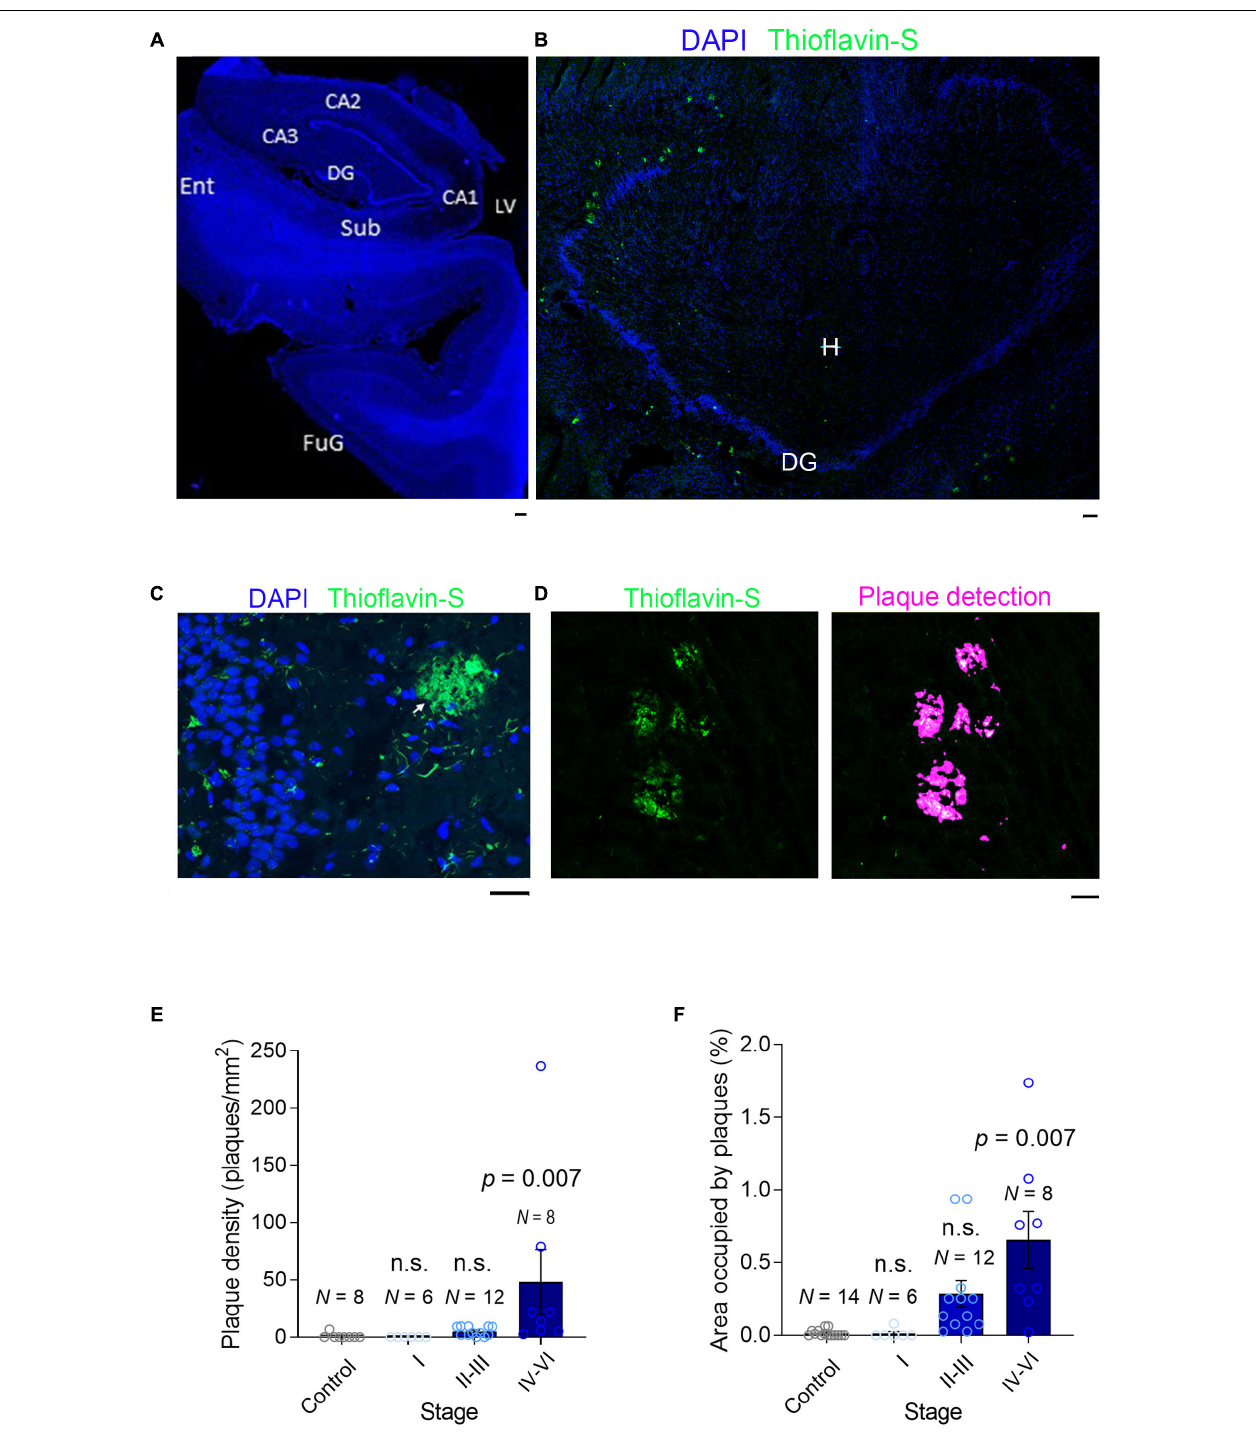
FIGURE 2 | Plaque detection in AD samples. (A) A slide scanner image ( × 5) of a DAPI-stained section (stage II) containing the hippocampal formation: Sub, Subiculum; Ent, Entorhinal Cortex; DG, Dentate Gyrus; LV, Lateral Ventricle; CA1-3, Cornu Ammonis; FuG, Fusiform Gyrus. (B) A confocal image ( × 10) of a section (stage V) containing mainly the dentate gyrus stained with DAPI (blue) and Thioflavin-S to detect the A β plaques (green): DG, Dentate Gyrus; H, Hilus. (C) High magnification image ( × 40) of the dentate gyrus (stage V) where small A β aggregates can be seen in the granule cell layer (GCL, green) and an extensive A β plaque is seen in the molecular layer (ML). (D) Left, Part of a section scanned with a slide scanner ( × 10) with A β plaques. Right, automatic detection of plaques, used to calculate the plaque density and the area occupied by plaques. (E,F) A bar graph showing the plaque density and the area occupied by plaque. N is the number of patients, and the data are presented as the average ± SEM. The scale bar in all the images is 50 µ m.